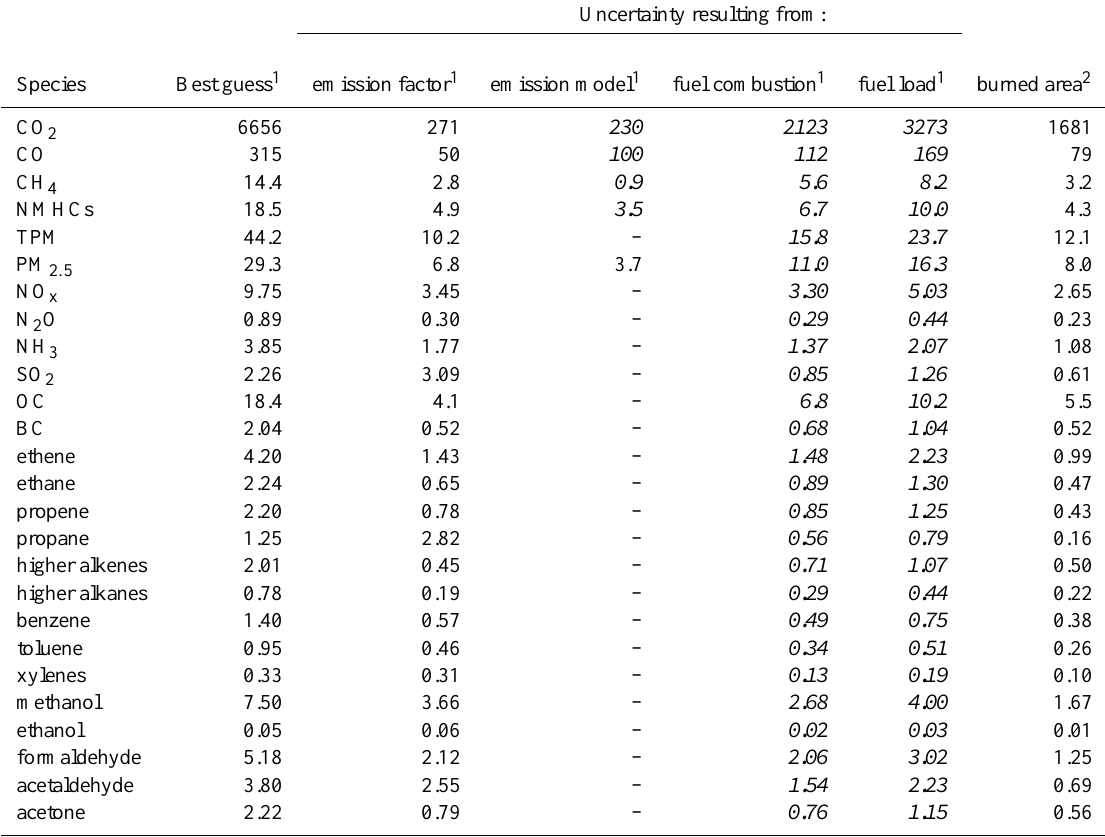
Table 4. Global wildfire emissions in Tgyr − 1 with Emission Model 1, c w = 0 . 2 and GFED3 burned area (best guess), and uncertainties from various factors. “Higher alkenes” and “higher alkanes” with a least 4C atoms. OC: organic carbon. BC: black carbon. NMHCs: non-methane hydrocarbons. TPM: total particulate matter. PM 2 . 5 particulate matter up to 2.5